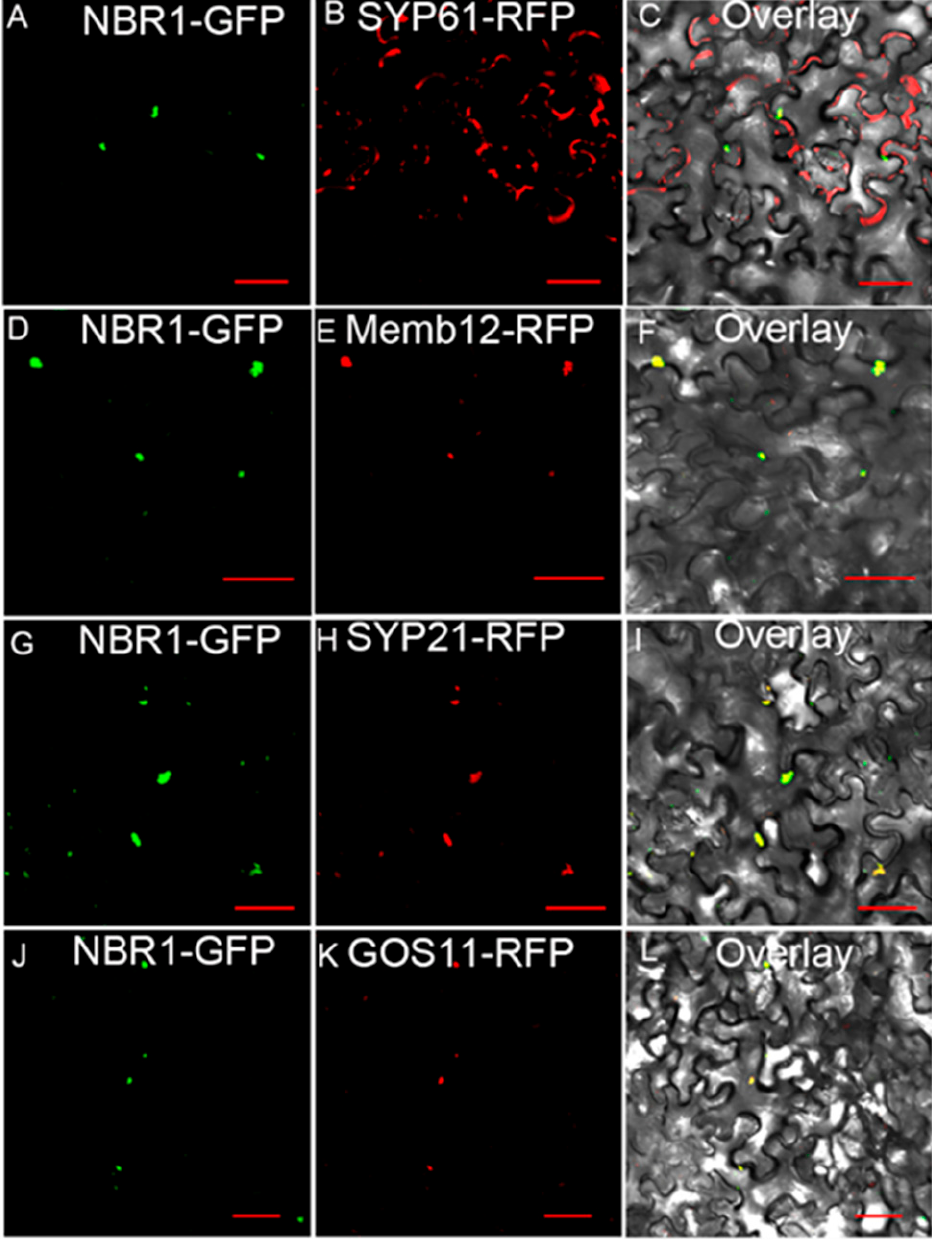
Figure 3. Subcellular localization of the TaNBR1 protein. 35S-NBR1-GFP and the indicated subcellular markers fused with fluorescent proteins were transformed into the epidermal cells of Nicotiana benthamiana . The single optical sections of the cells were imaged by confocal laser scanning microscopy. NBR1-GFP ( A ) is partially associated with the trans-Golgi network localized protein AtSYP61-RFP ( B ), as demonstrated in the overlay ( C ). NBR1-GFP ( D ) and AtMemb12-RFP ( E ) localized with the cis-Golgi localized marker, as demonstrated in the overlay ( F ). NBR1-GFP ( G ) co-localized with the prevacuolar compartment/late endosomes (PVC/LEs) marker AtSYP21-RFP ( H ), as demonstrated in the overlay ( I ). NBR1-GFP ( J ) co-localized with the trans-Golgi localized marker AtGos11-RFP ( K ), as demonstrated in the overlay ( L ). Bar = 50 µm. 2.4. The Characteristics of TaNBR1 Overexpressing Transgenic Arabidopsis To determine the function of TaNBR1 , the recombinant plasmid 35S: TaNBR1-EGFP was transferred into the Agrobacterium tumefaciens strain GV3101 and then transformed into Arabidopsis . Three homozygous transgenic T3 lines designated as OE-6, OE-10, and OE-15 were then investigated by Western blot analysis (Figure 4D). The 3 transgenic lines and WT control were cultured under the same conditions for 3 weeks; after not being watered for 2 weeks, most of the leaves wilted and withered in the TaNBR1 transgenic lines, but the WT control lines continued to grow normally. Subsequently, after re-water- ing for 3 days, most of the transgenic lines did not survive, whereas the WT plants exhib- ited relatively good resilience and normal growth was restored (Figure 4A). Therefore, the survival rates of the transgenic plants were lower than those of the WT control (Figure 4C). In addition, the TaNBR1 transgenic plants had relatively higher water loss rates and lower relative water contents, in comparison to the control according to the measurements of the relative water contents and water loss rates (Figure 4D,E). Therefore, these results suggest that the overexpression of TaNBR1 can reduce drought resistance in Arabidopsis .